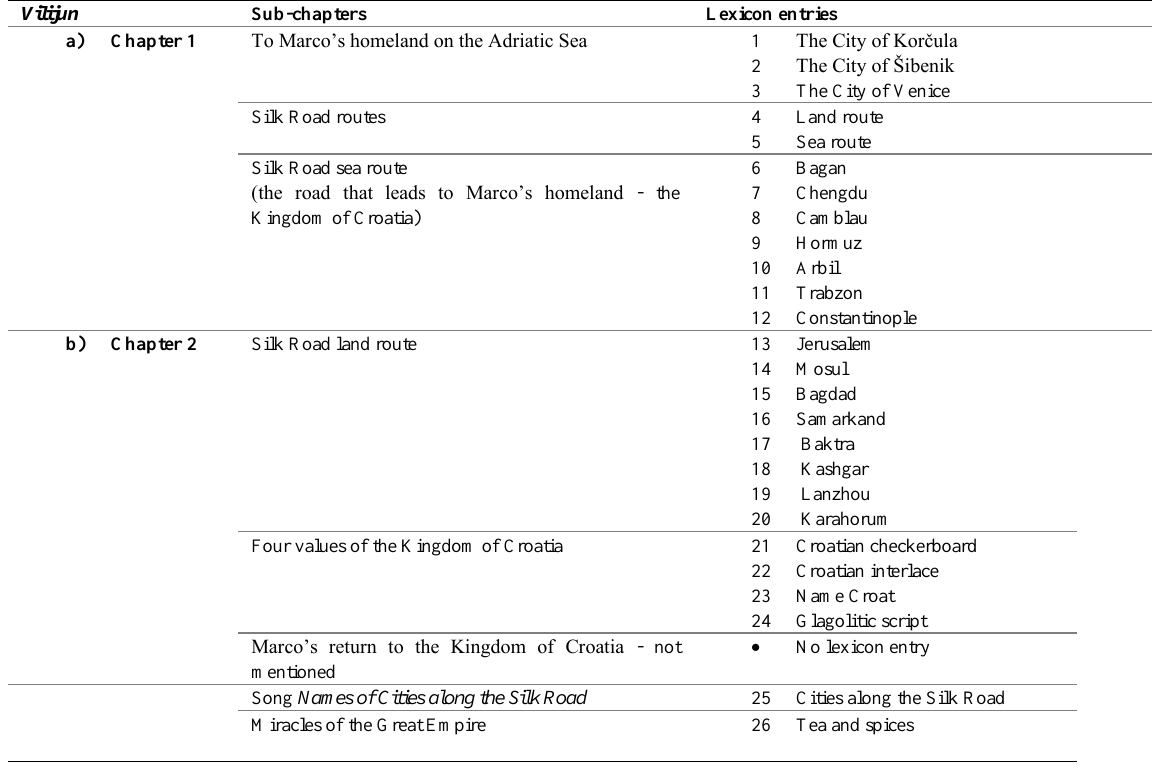
Table 2: Information on Croatian-Chinese cooperation offered in the Vilijun